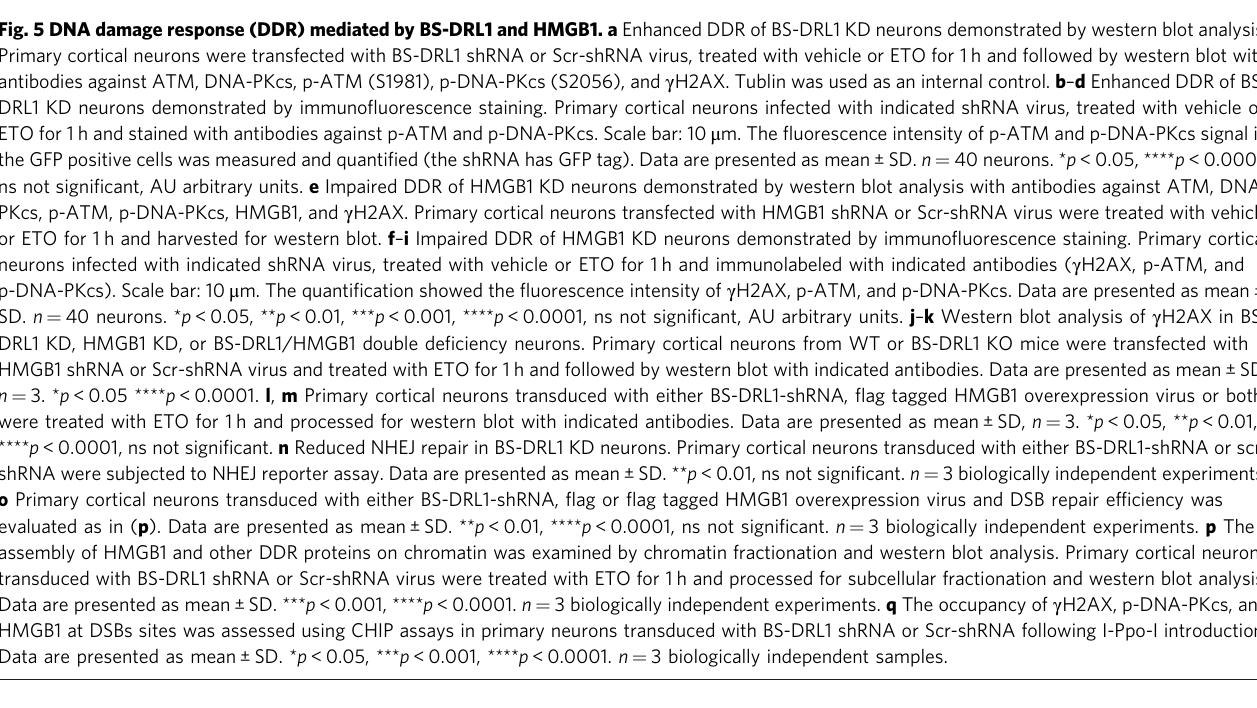
Fig. 5 DNA damage response (DDR) mediated by BS-DRL1 and HMGB1. a Enhanced DDR of BS-DRL1 KD neurons demonstrated by western blot analysis. Primary cortical neurons were transfected with BS-DRL1 shRNA or Scr-shRNA virus, treated with vehicle or ETO for 1 h and followed by western blot with antibodies against ATM, DNA-PKcs, p-ATM (S1981), p-DNA-PKcs (S2056), and γ H2AX. Tublin was used as an internal control. b – d Enhanced DDR of BS- DRL1 KD neurons demonstrated by immuno fl uorescence staining. Primary cortical neurons infected with indicated shRNA virus, treated with vehicle or ETO for 1 h and stained with antibodies against p-ATM and p-DNA-PKcs. Scale bar: 10 μ m. The fl uorescence intensity of p-ATM and p-DNA-PKcs signal in the GFP positive cells was measured and quanti fi ed (the shRNA has GFP tag). Data are presented as mean ± SD. n = 40 neurons. * p < 0.05, **** p < 0.0001, ns not signi fi cant, AU arbitrary units. e Impaired DDR of HMGB1 KD neurons demonstrated by western blot analysis with antibodies against ATM,